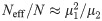
Random graphs suppress weak selection.Plot markers show the ratio Neff/N, averaged over 1000 trials, plotted against population size N. Effective population size, Neff, is calculated by numerically solving Eq (5) for each graph and applying Eqs (6) and (9). All random graphs generated have Neff < N and are therefore suppressors of weak selection. Curves of the corresponding colors show the approximation Neff/N≈μ12/μ2 from Eq (24). Overall, we find that larger, sparser, and more heterogeneous graphs have smaller Neff/N; these trends are all reflected in the approximation from Eq (24). (A) Erdös-Renyi graphs were generated for specific values of the expected degree 〈k〉 by setting the link probability to p = 〈k〉/(N − 1). The moments μ1 and μ2 were approximated by assuming that the degree of each vertex is independently distributed as Binom(N − 1, p). This leads to Neff/N ≈ (N − 1)p/[(N − 2)p + 1]. At the minimum population size of N = 〈k〉+ 1, the graph is complete and therefore Neff/N = 1. (B) Barabási-Albert preferential attachment networks [64] were generated for linking numbers 3 ≤ m ≤ 6, starting from a complete graph of size m + 2. The second moment was calculated using the expected degree distribution for finite Barabási-Albert networks obtained by Fotouhi and Rabbat [65]. At the minimum population size of N = m + 2, the graph is complete and therefore Neff/N = 1.